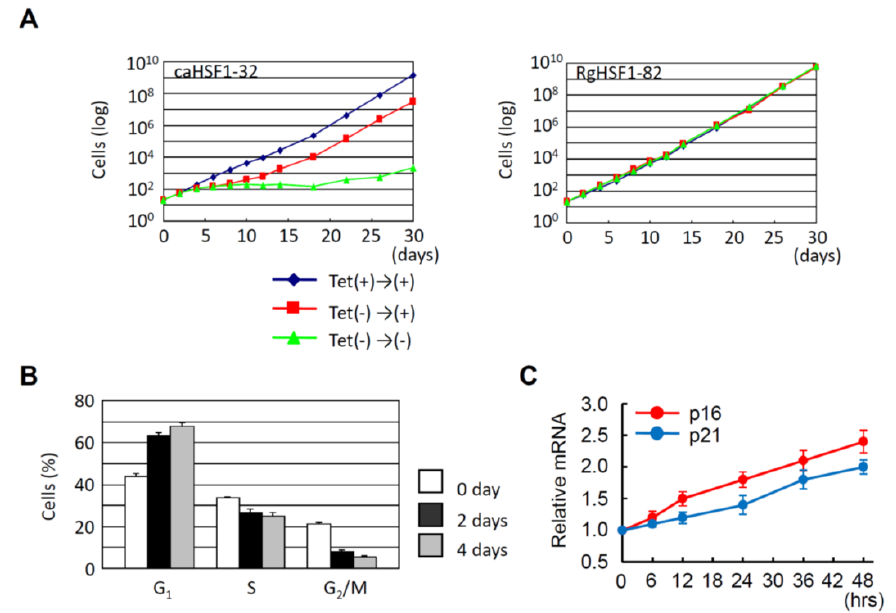
Figure 2. HeLa cell proliferation is inhibited by constitutive active HSF1 (caHSF1). ( A ) caHSF1 expression dramatically inhibits cell proliferation ( left ). In contrast, DNA binding activity lacking mutant HSF1 (RgHSF1) expression does not affect cell proliferation ( right ). ( B ) Change of cell proportion in G 1 , S, and G 2 /M phases by the induction of caHSF1 expression. G 1 proportion increases and G 2 /M proportion decreases. ( C ) mRNA expression of p16 and p21 increases by the induction of caHSF1 expression.